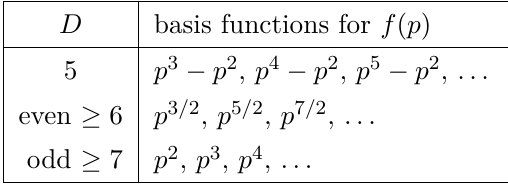
Table 1 . Basis functions for f ( p ) appearing in the linear program (3.16). The technical reasons for these choices are explained in appendix A.1. table 1. 11 For the functions h ( p ) , we simply expand them in nonnegative integer powers: k p 0 , p 1 , . . .